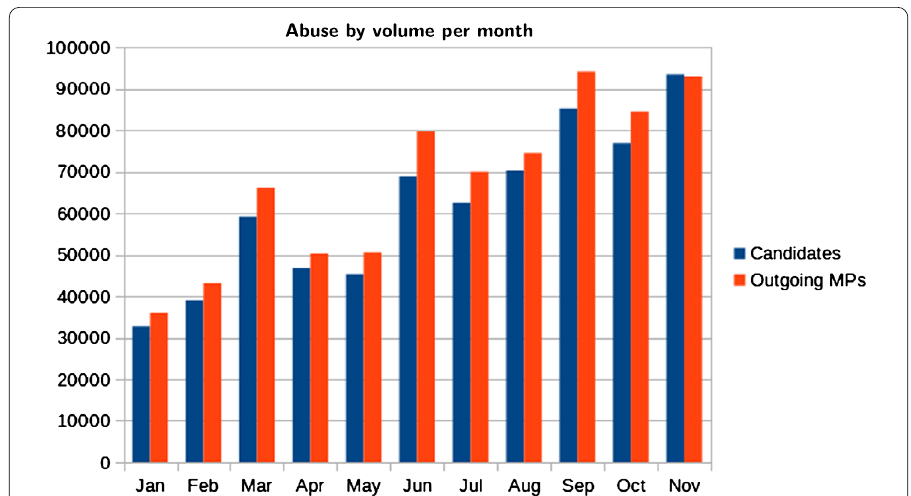
Figure 1 Abuse by volume per month. Abuse received by candidates (including those standing for re-election) alongside that received by outgoing MPs (not standing again) per month across 2019. Individuals who are both previous MPs and candidates appear in both columns